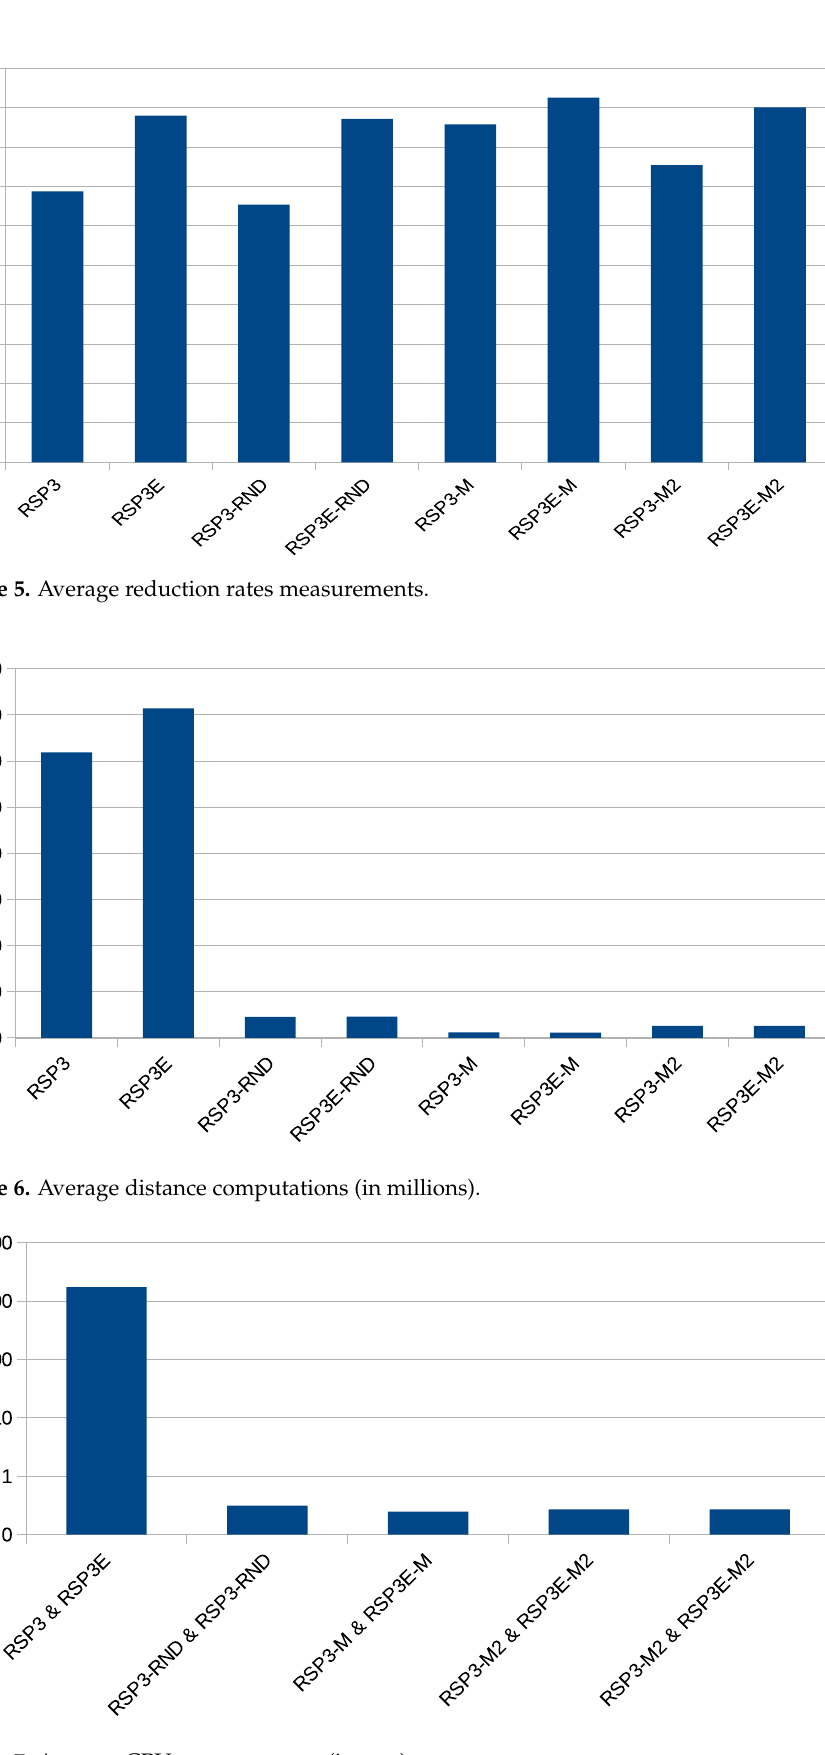
Figure 7. Average CPU measurements (in